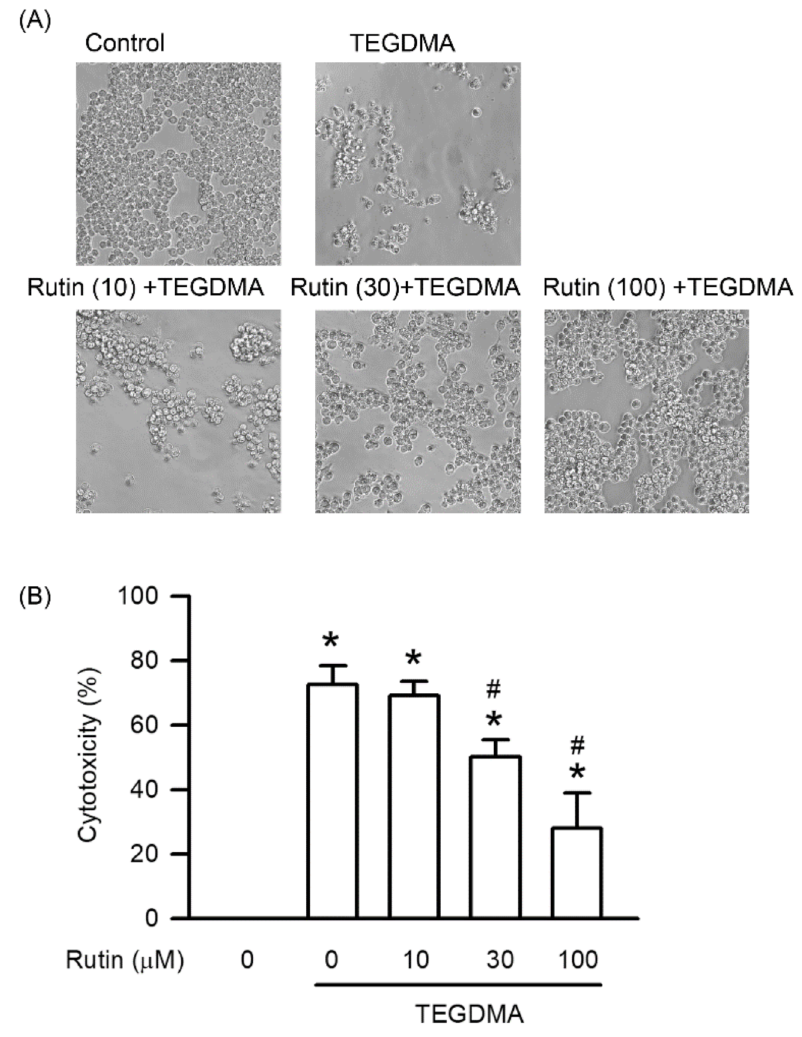
Figure 1. Effect of rutin on TEGDMA-induced cytotoxicity in RAW264.7 macrophages. After RAW264.7 macrophages were incubated with rutin at 0, 10, 30, and 100 µ M for 30 min, the cells were incubated with or without TEGDMA at 3 µ M for 24 h. ( A ) The image of morphological changes was taken using the inverted microscope at the actual magnification 200 × . ( B ) Cytotoxicity was repre- sented as the percentage of the control group, which indicated 0% cytotoxicity rate in the treatment with TEGDMA and rutin at 0 µ M. Values are expressed as mean ± S.D. of three times per group. * Represents significant difference between the indicated and control groups; # between the indicated and TEGDMA groups, p <